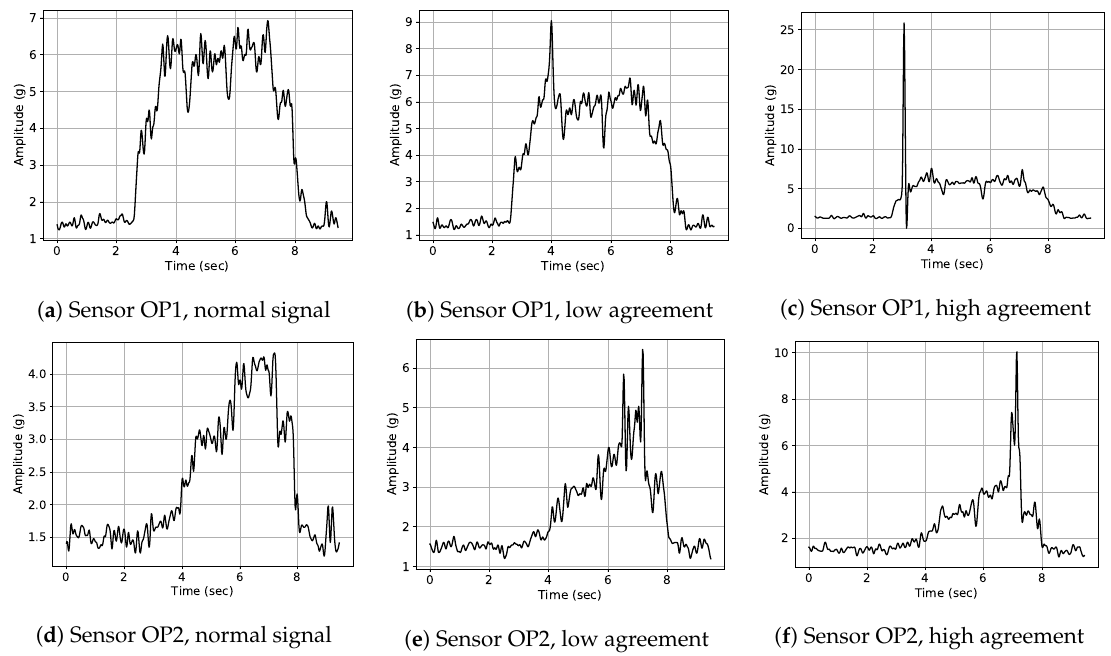
Figure 11. Example signals for high and low inter-annotator disagreement: Examples with high agreement illustrate typical “Whirr” patterns, while examples with low agreement are characterized by more subtle signal